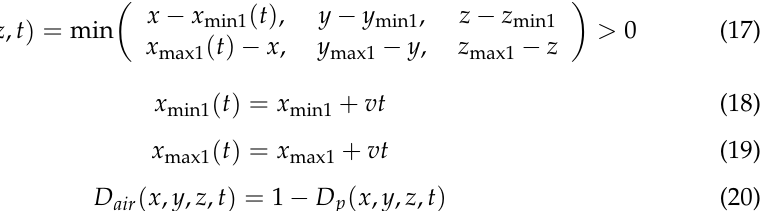
tively. Next, set the implicit functions for each region: